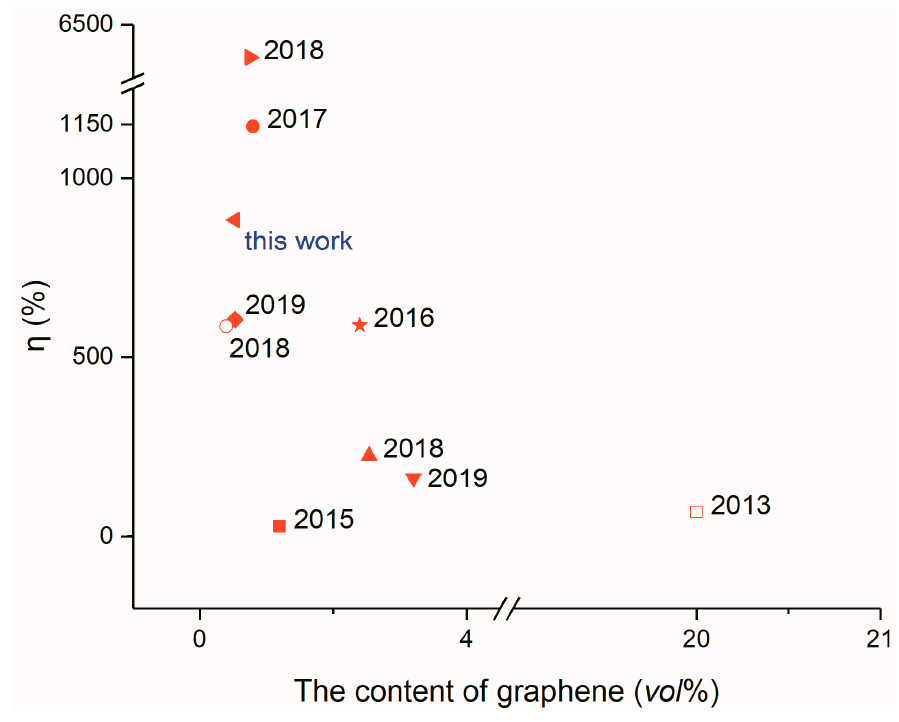
Figure 16. Comparison of thermal conductivity enhancement of graphene/paraffin composites ( ■ [47] ● [46] ▲ [49] ▼ [50] ► [33] ◆ [51] ★ [34] □ [52] ○ [53] ).